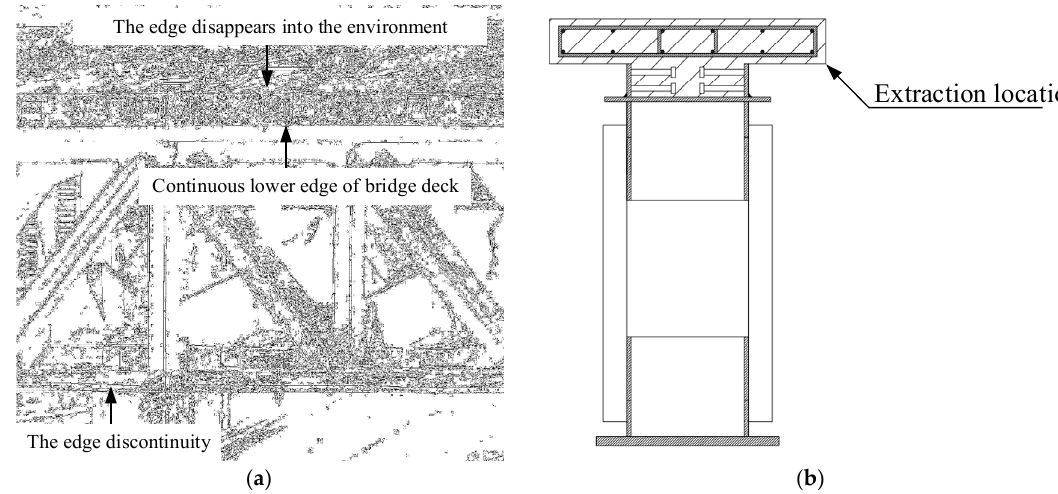
Figure 11. Feature contour extraction; ( a ) edge of the test beam affected by environment; ( b ) sketch map of edge extraction position.